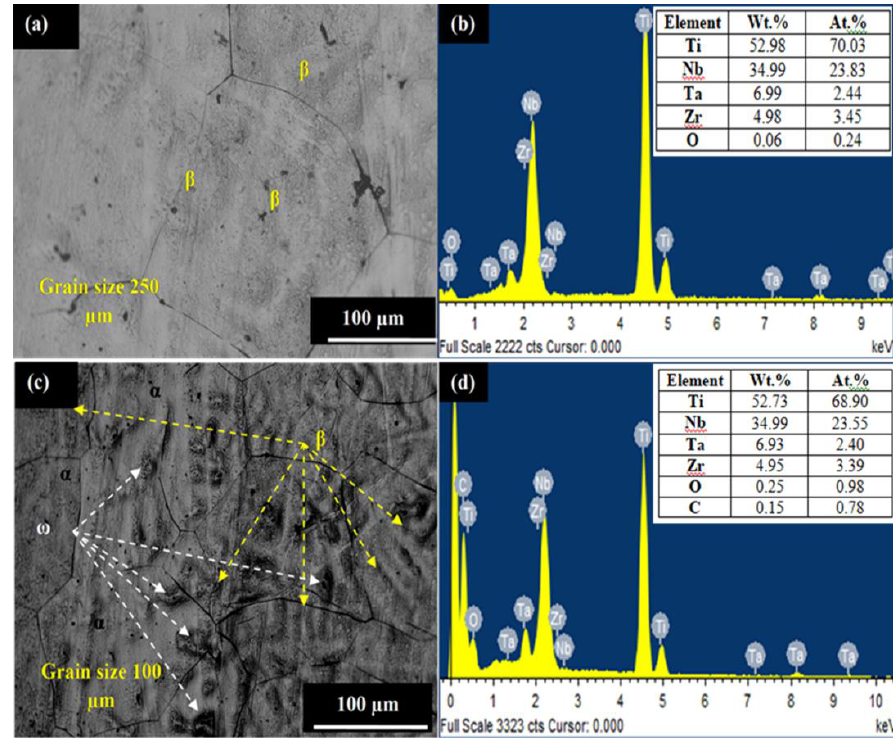
Figure 1. Microstructure and EDS spectrum: ( a , b ) β-TNTZ and ( c , d ) β-TNTZ after heat treatment